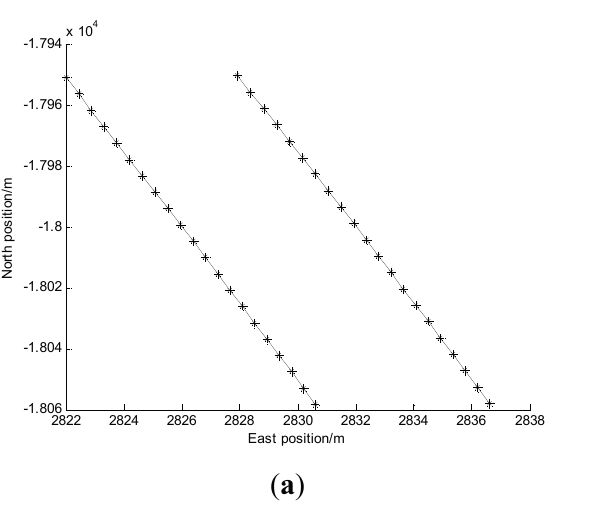
Figure 5. Setting the shapes of the tunnels: ( a ) Straight tunnel ( b ) Curved